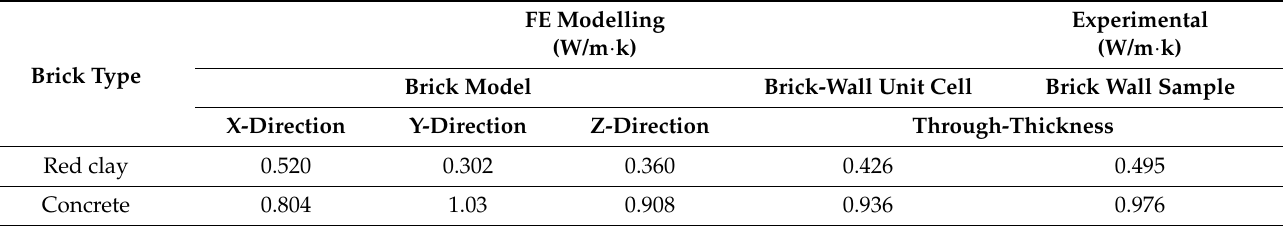
Table 2. Thermal conductivity results obtained from the finite element procedure and experimental work. FE Modelling Experimental (W/m · k) (W/m · k) Brick Type Brick Model Brick-Wall Unit Cell Brick Wall Sample X-Direction Y-Direction Z-Direction Through-Thickness Red clay 0.520 0.302 0.360 0.426 0.495 Concrete 0.804 1.03 0.908 0.936